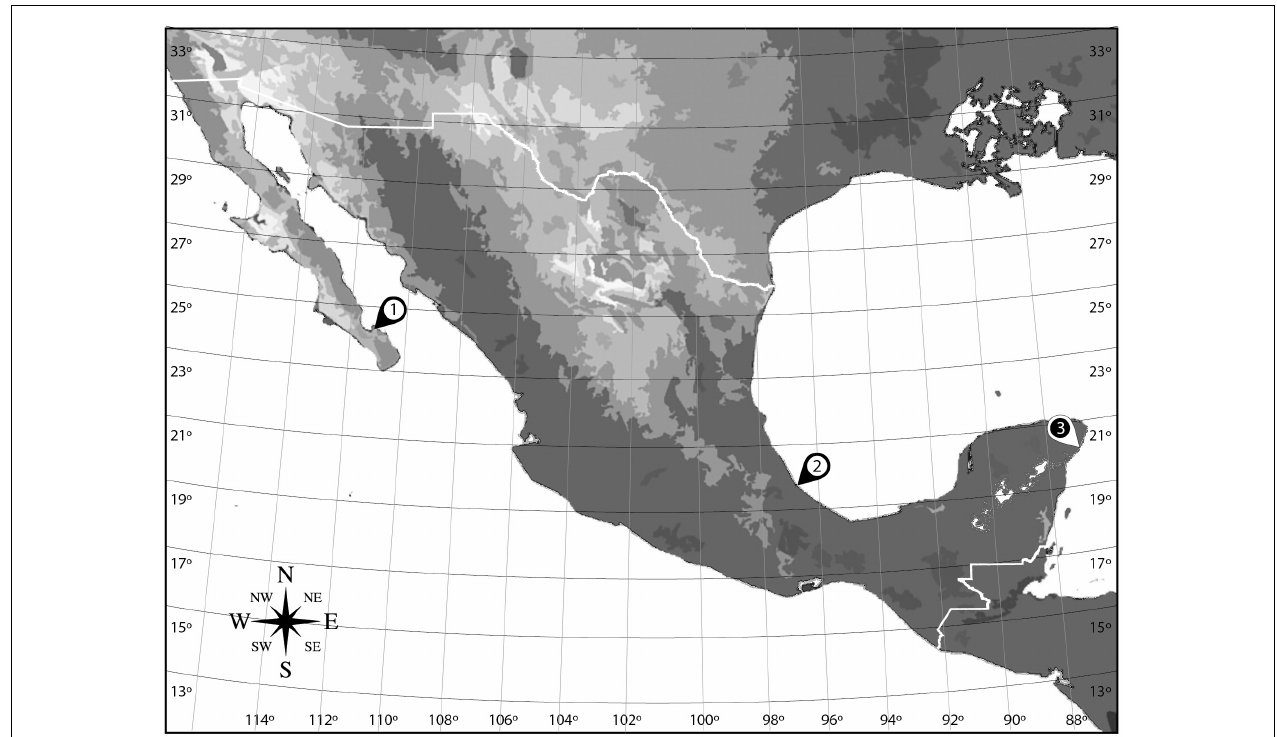
FIGURE 1 | Map of the sampling localities for Prorocentrum isolates from the Gulf of California, Gulf of Mexico, and Caribbean coasts of Mexico. (1) Bahía de La Paz, Baja California Sur. (2) Veracruz Reef System, Veracruz. (3) Puerto Morelos, Quintana